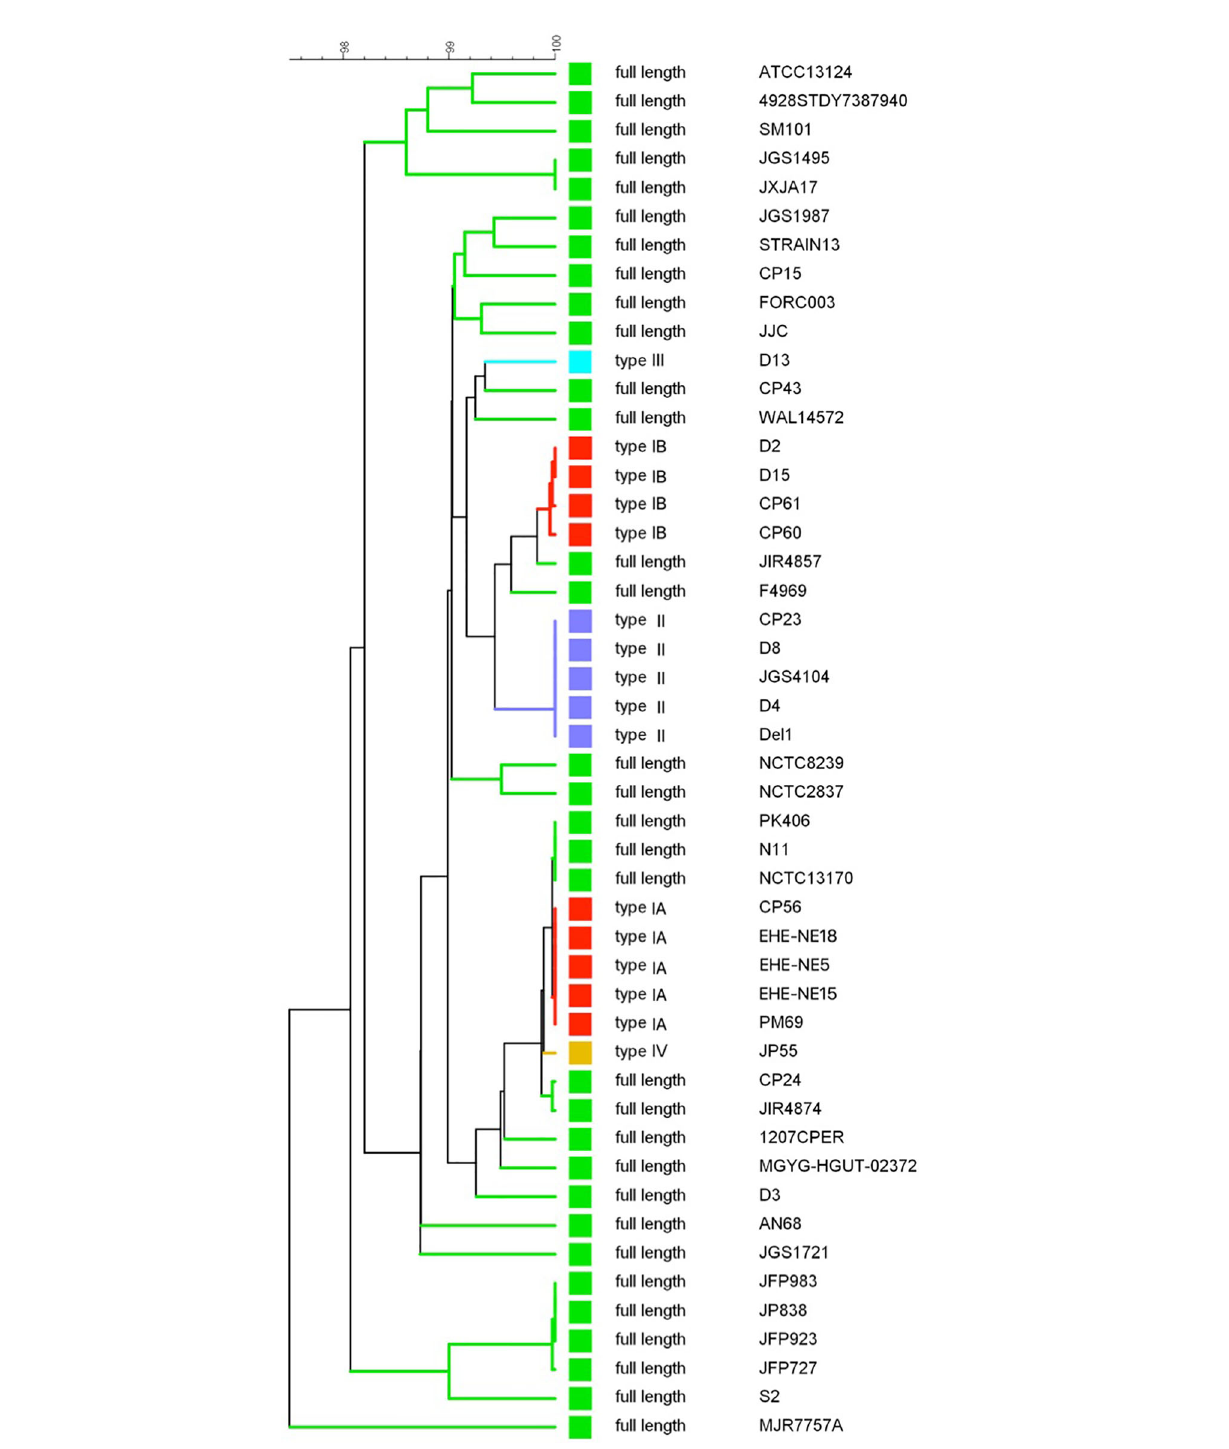
FIGURE 4 | colA gene based dendrogram re fl ecting the similarity for 48 C. perfringens strains. A UPGMA phylogenetic tree was constructed based on the colA gene sequences (i.e. full gene sequences - from original start to original stop codon - including both fragments when nonsense mutations leading to premature stop codons are present). Sequence similarity percentages (top bar) are shown. Colored branches depict collagenase variant types (see Figure 3 , Green, full-length; Red, collagenase type I variant; Blue, collagenase type II variant; Light blue, collagenase type III variant; Orange, collagenase type IV variant). Branch labels include the C. perfringens strains from which the colA gene sequence was